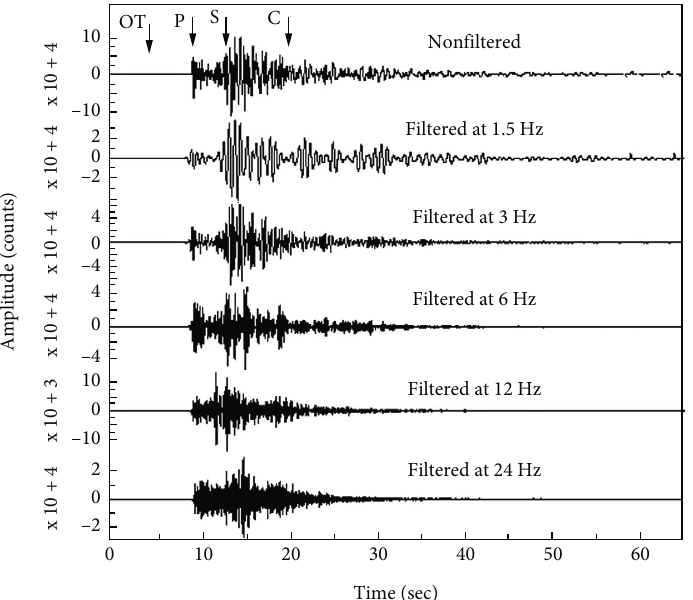
Figure 5: Example of original and band pass- fi ltered seismograms (Z component) for central frequencies at 1.5, 3, 6, 12, and 24Hz, respectively, for the local earthquake (2007/07/24) with M4.4 and epicentral distance of 30 km recorded at station AKHA. Arrows indicate origin time, P, S, and coda waves ’ arrivals.